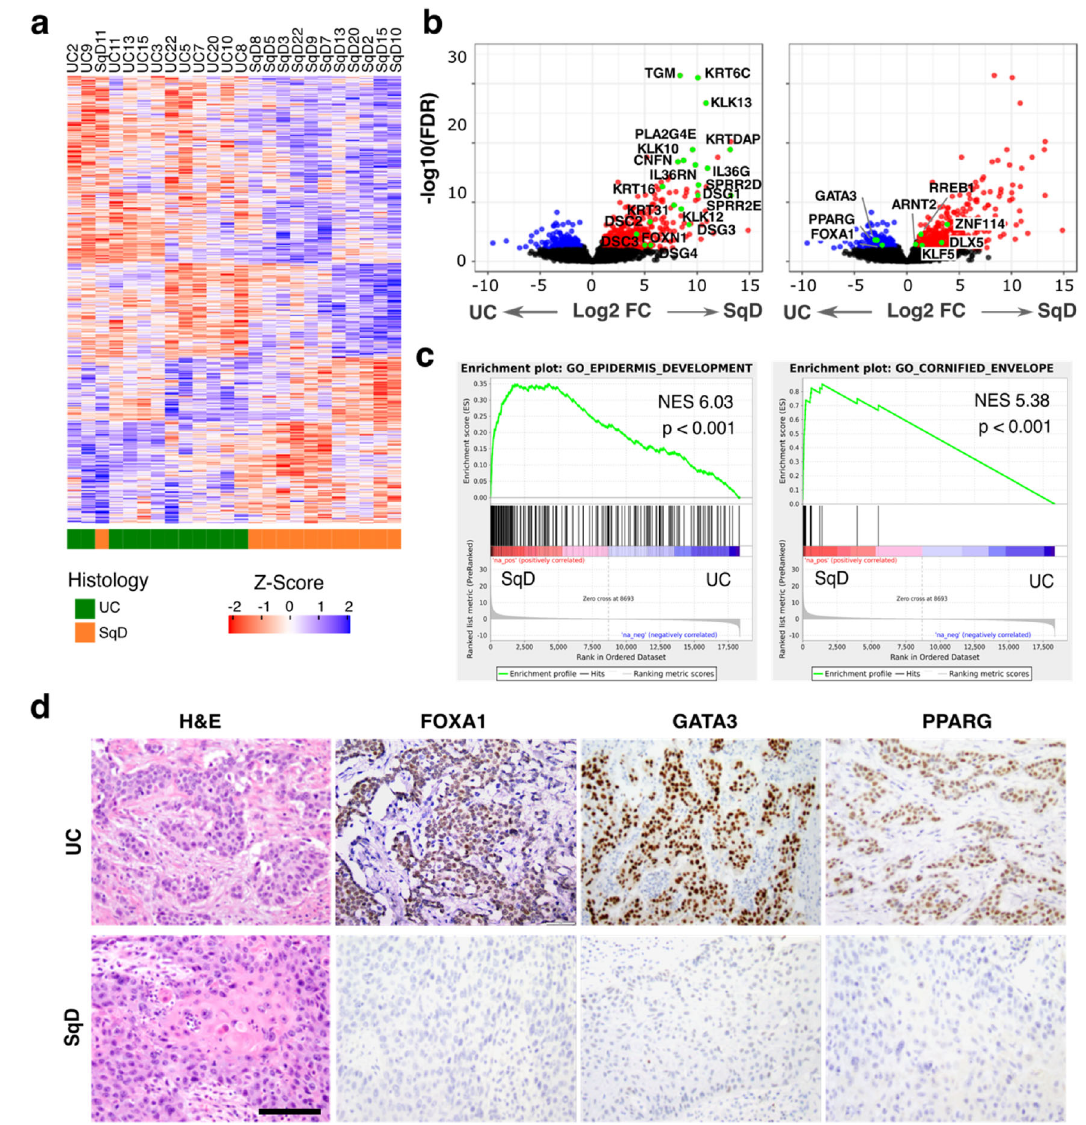
Fig. 3 | SqD regions are characterized by loss of expression of the FOXA1, GATA3, and PPARGtranscriptionfactors.a Differentialgene expression analysis of RNAseq data from 12 biologically independent samples following macrodissec- tion of paired UC and SqD regions revealed 718 signi fi cantly upregulated and 651signi fi cantlydownregulatedgenesintheSqDversustheUCregions(de fi nedas log2 FoldChange >1 and FDR<0.05). b Volcano plot of the same 12 UC-SqD pairs showingdifferentiallyexpressedgeneswithlogFoldChangeonthex-axisandlog p - valueonthey-axis.Highlightedaregenesassociated withurothelialdifferentiation